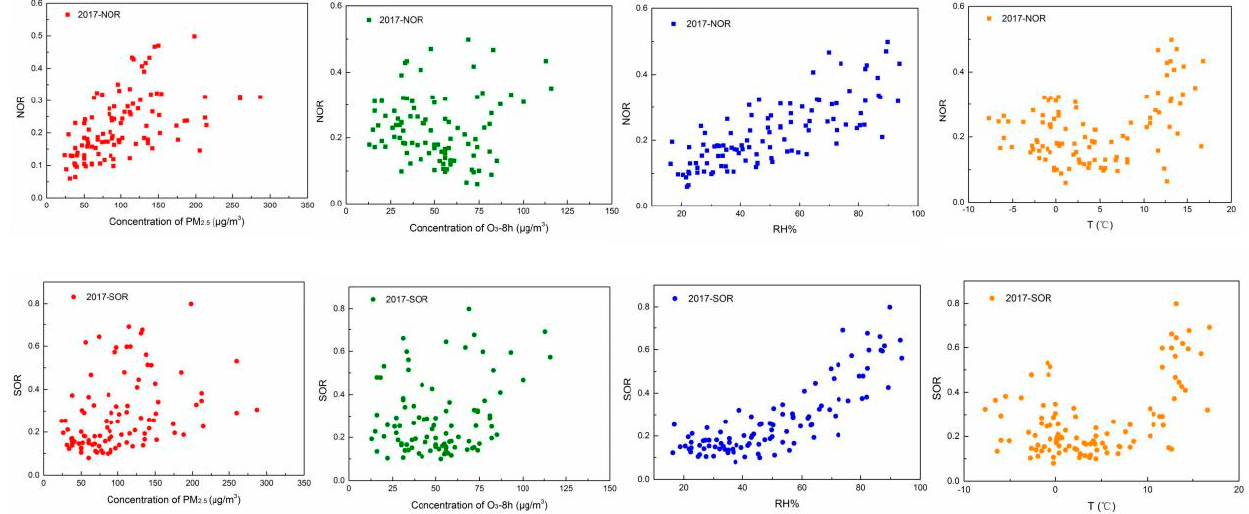
Figure 7. Correlations of SOR and NOR against PM 2.5 and O 3 concentration, relative humidity and temperature in the autumn-winter season of 2017–2018.